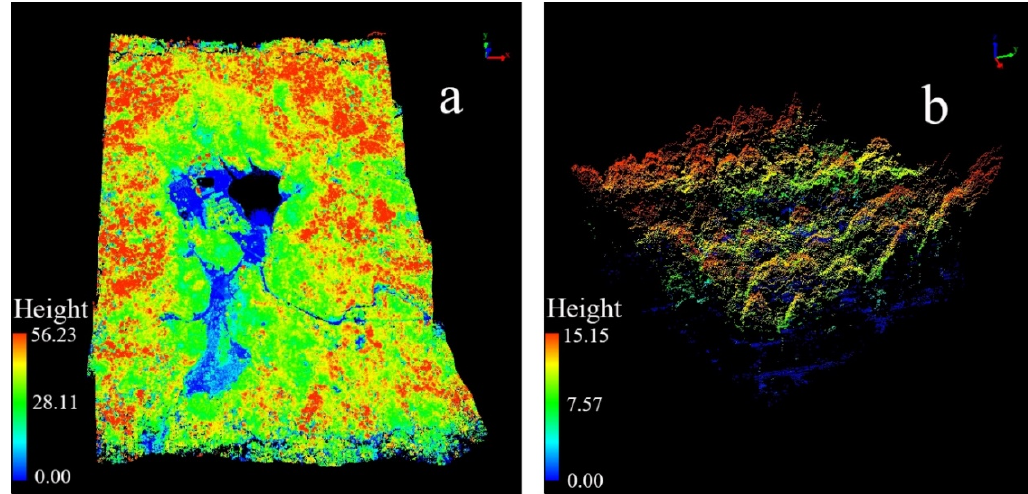
Figure 2. ( a ) The normalized three-dimensional point cloud image of DLS, and ( b ) the three-dimensional structure map of a certain place in DLS.